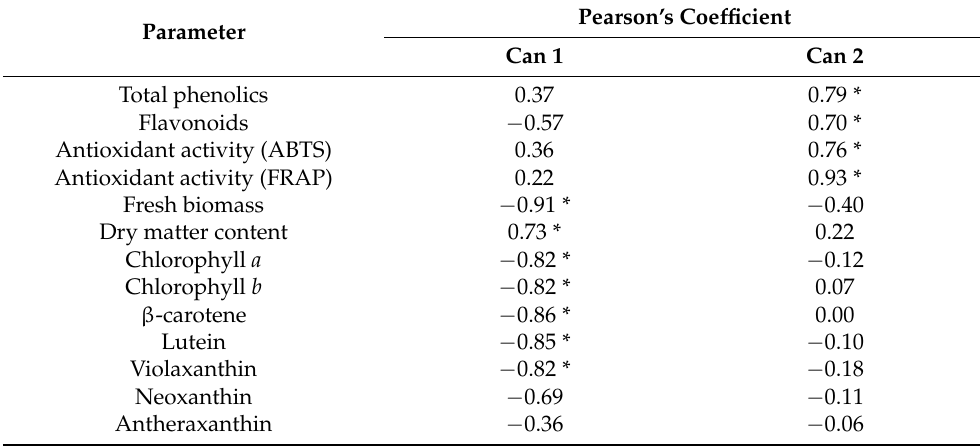
Table 4. Pearson’s correlation coefficients (r) between each parameter measured and the canonical scores associated with the canonical discriminant analysis (CDA) reported in Figure 2. * 0.7 ≥ |r| ≥ 1: strong